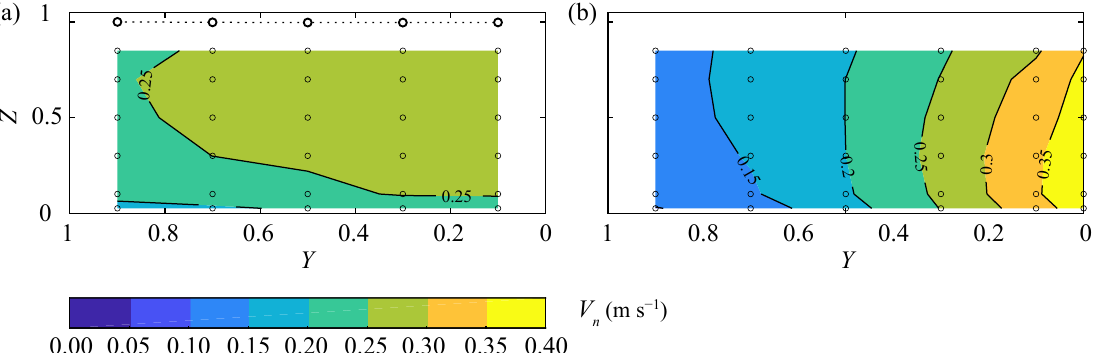
Figure 15. Values of V n measured in the rack-parallel cross section directly in front of the rack S4, α = 30 ◦ , s b = 20 mm, H Ov = 0 at ( a ) a diversion hydropower plant layout and ( b ) a block-type hydropower plant layout without weir